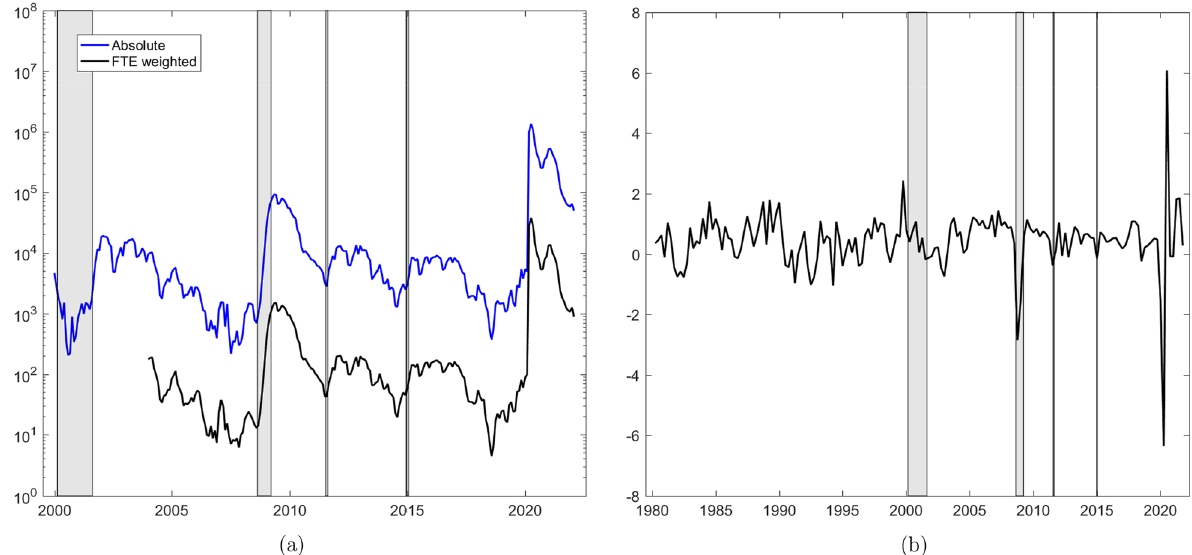
Fig. 1 Time series. a Short-time workers (download May 25, 2022), total of absolute numbers across sectors (Absolute) and total across sectors weighted by division-specific full-time-equivalent employment (FTE weighted). Monthly frequency, logarithmic scale. b Real GDP growth (vintage 22Q1), quarterly frequency, percentage scale. Gray bars highlight the dotcom and financial crises, the introduction and discontinuation of the euro-Swiss franc floor. Notes: Short-time workers, concatenated data: Published pdf-file (https:// www. seco. admin. ch/ seco/ de/ home/ Arbeit/ Arbei tslos enver siche rung/ leist ungen/ kurza rbeit sents chaed igung. html) as of May 1, 2020, January 2000 to December 2003; download (https:// www. amstat. ch/ Micro Strat egy/ servl et/ mstrW eb) as of May 25, 2022, January 2004 to February 2022. Division-specific full-time equivalent employment: Data for 2019, obtained from FSO by e-mail as of June 20, 2022. GDP growth: Vintage 22Q1, Download (https:// www. seco. admin. ch/ seco/ de/ home/ wirts chaft slage —wirts chaft spoli tik/ Wirts chaft slage/ bip- quart alssc haetz ungen-/ conce pts–en–. html) as of May 28, 2022. The shaded dotcom crisis spans the burst of the bubble in March 2000 up to the Enron scandal in October 2001. The shaded area of the financial crisis spans from September 2008 (Lehman Brothers insolvency) to April